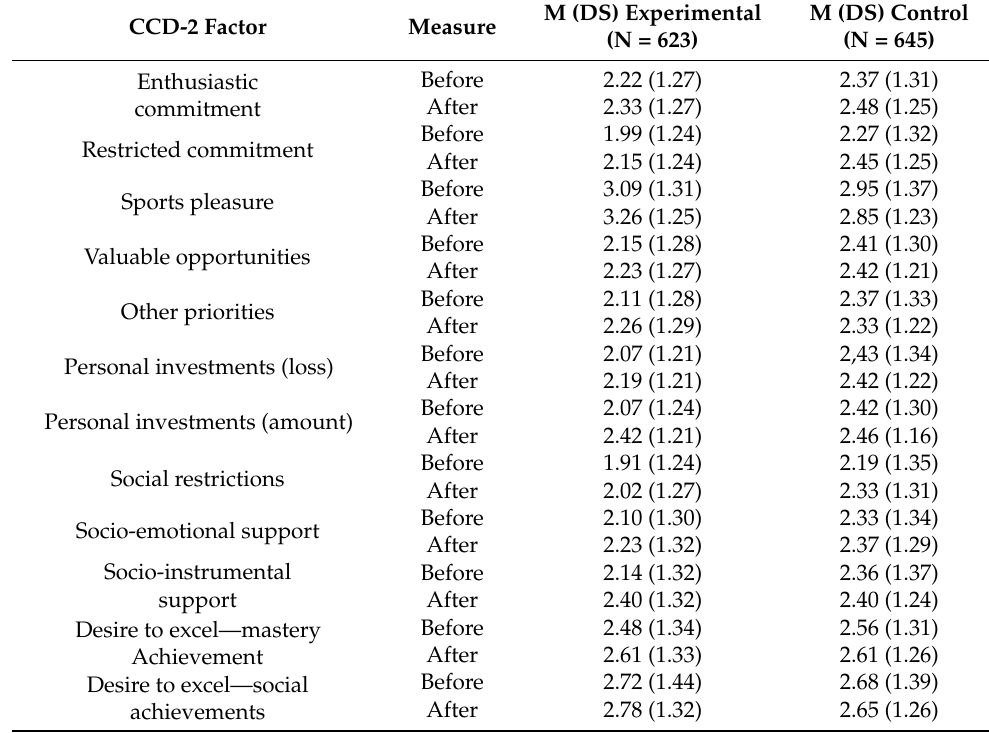
Table 2. Pre-test and post-test measurements and standard deviations by group and CCD-2 factor. CCD-2